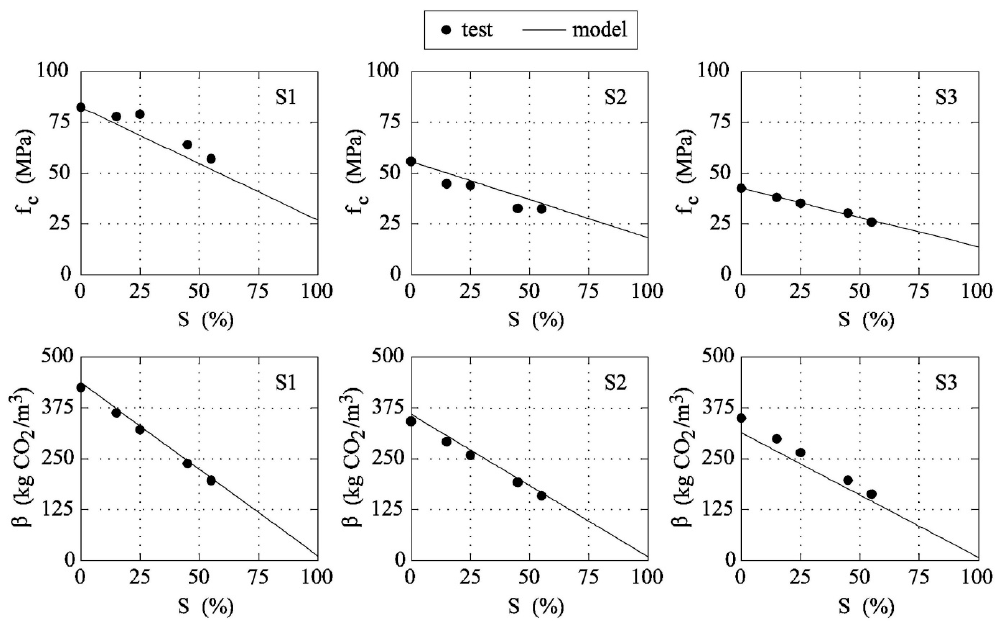
Figure 3. The proposed functions f c - S and β - S compared with test data measured by Lam et al. [11].